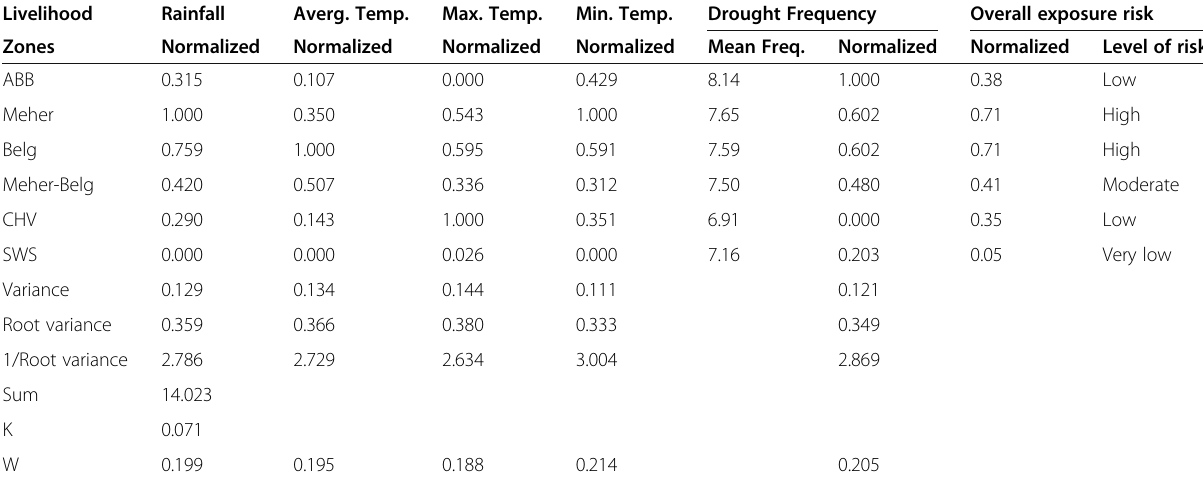
Table 2 Normalized rainfall, temperature, drought frequency, and overall level of exposure risk across the livelihood zones of the study